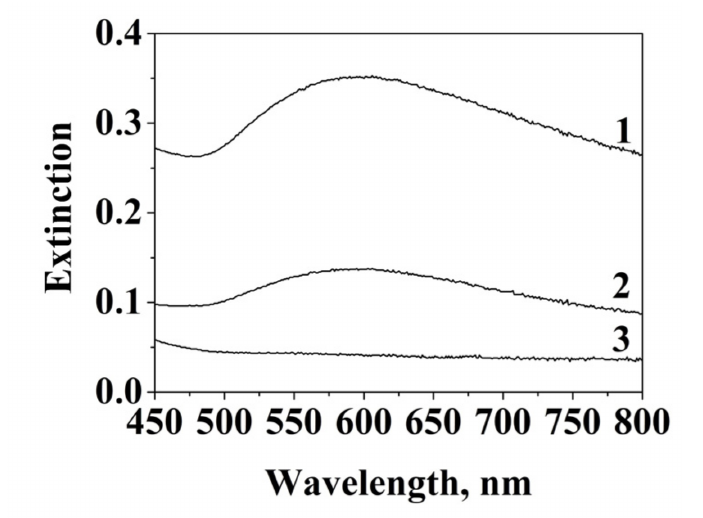
Figure 6. Optical absorption spectra of CoFe 2 O 4 nanoparticles before (3) and after (1) 1 gold depo- sition cycle from the alkaline (pH = 12) solution containing 0.6 mmol/L HAuCl 4 and 0.03 mol/L methionine at 37 ◦ C for 4 h, and spectra of solution (2) remaining after CoFe 2 O 4 /Au nanoparticles (NPs) magnetic